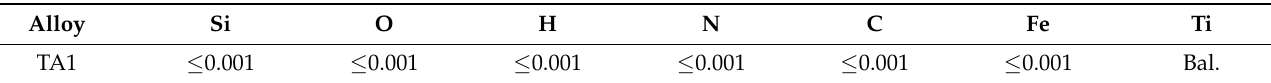
Table 2. Chemical compositions of TA1.